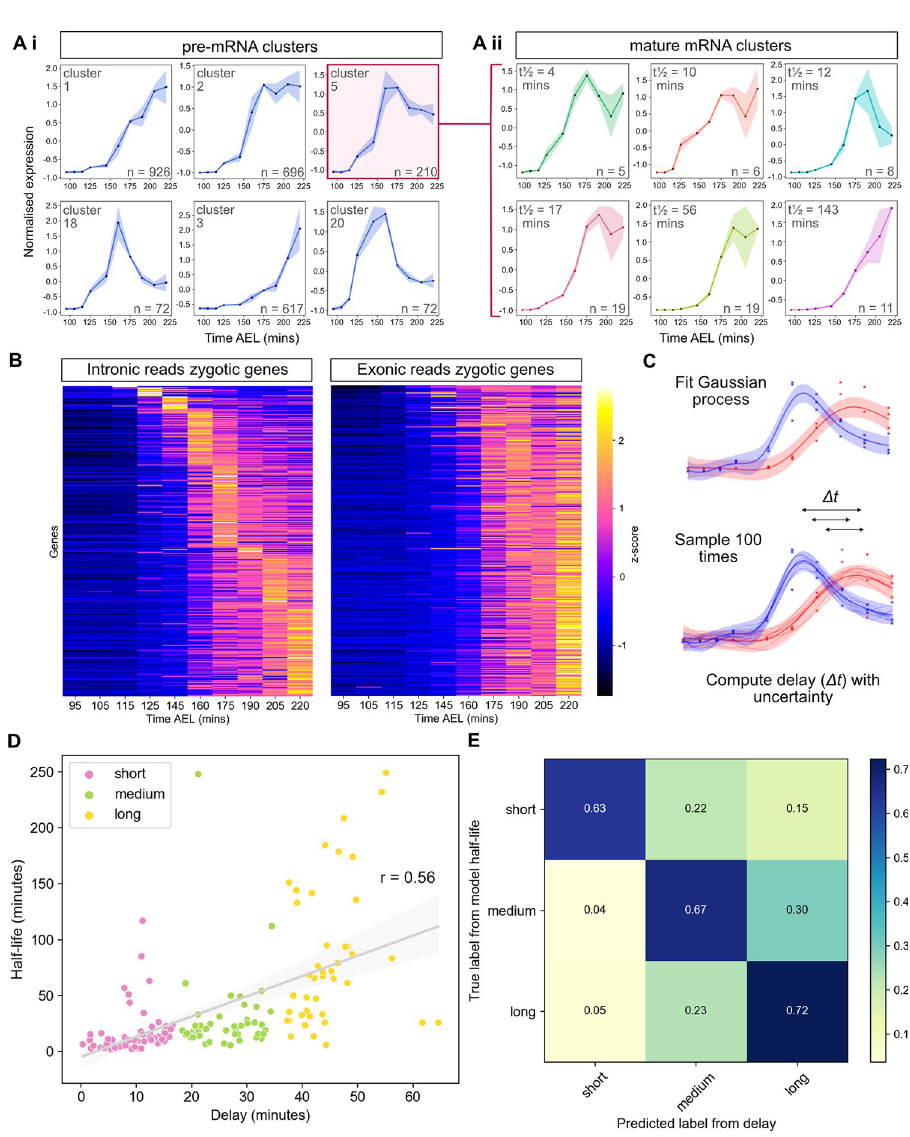
Fig 3. Degradation regulates mRNA dynamics and can be approximated using the time delay between peak pre- mRNA and mature mRNA expression. (A) Clustering of pre-mRNA (Ai) and mature (Aii) mRNA time series. Plots show the mean expression value at each time point for all mRNAs in a cluster and the shaded area shows the standard deviation. The intronic cluster ID (Ai) or mean half-life (Aii) is shown in the top left and the number of transcripts in each cluster in the bottom right. (B) Heatmaps of pre-mRNA and mRNA expression at the gene-level for the subset of zygotic transcripts, ordered by the time point of maximum pre-mRNA expression. (C) Schematic illustrating the estimation of temporal delays between pre-mRNA and mature mRNA peak times ( Δ t , arrows) by fitting and sampling from a GP. (D) Correlation of the delay between the peak of pre-mRNA and mature mRNA against inferred half-life (Pearson’s r = 0.56, p = 6.5 × 10 − 14 for testing non-correlation). Points representing transcripts are coloured by time delay category. (E) Confusion matrix comparing mRNAs categorised into short, medium, and long delays and their respective half-life categories. Numbers in the boxes indicate the fraction of mRNAs with a given delay in the corresponding half-life category. Underlying data can be found in S1 Data and S4 Table. GP, Gaussian process.